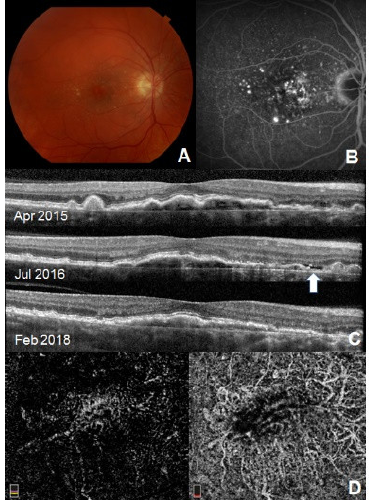
Figure 2. Multimodal imaging of the right eye of the same patient as in Figure 1. Visual acuity is 20/20. ( A ) Fundus photography of the right eye shows pigmentary changes with drusen in macula. ( B ) Late-phase FA shows staining without active fluorescent leakage. ( C ) SD-OCT reveals irregular elevated RPE elevation with moderately reflective material in the sub-RPE space with fluctuating subretinal fluid over the follow-up period (Arrow, SRF) ( D ) OCT-A segmented on the outer retina ( left ) and choriocapillaris ( right ) layer showing vascular network under fovea suggestive of ‘quiescent CNV’. Reprinted with permission from ref. [35]. Copyright 2020, SAGE publishing.